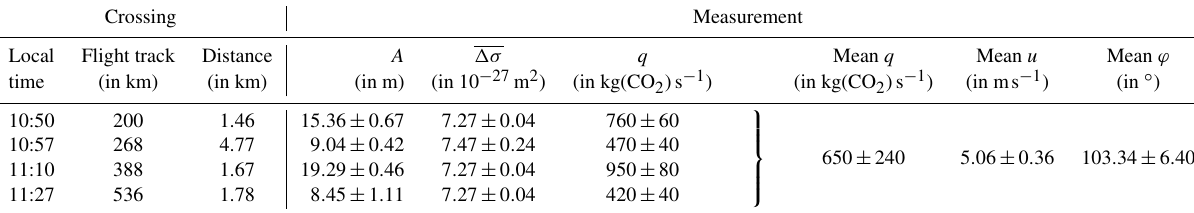
Table 1. Flight measurement results of individual crossings for the Jänschwalde power plant on 23 May 2018, following the nomenclature of Eq. (3).